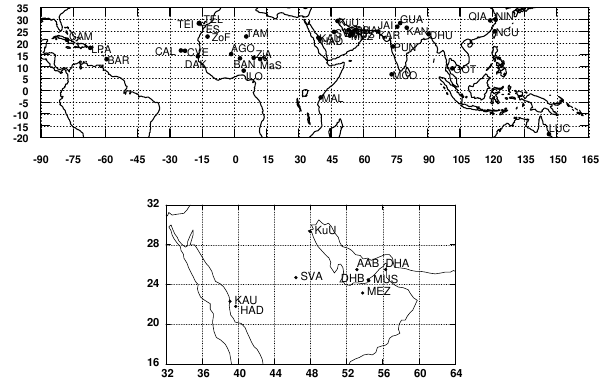
Figure 1. Location of the 38 AERONET sites selected for this study. Top: whole tropical belt; bottom: zoom of the Arabian Peninsula. See Table 1 for the meaning of the three-letter